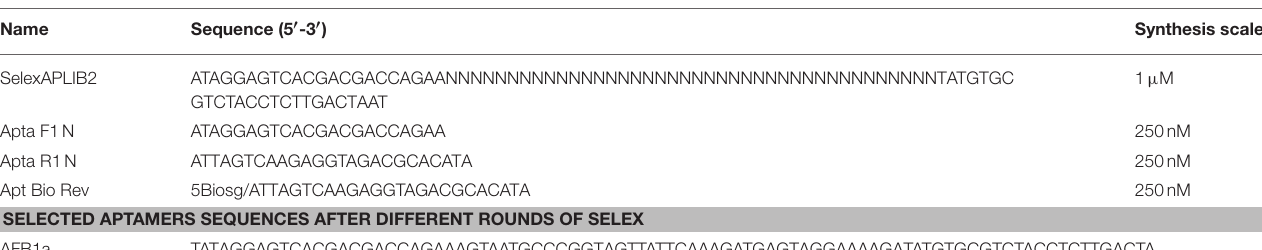
TABLE 1 | Primers used in Aptamers generation and sequence selected aptamers (AFB1a and